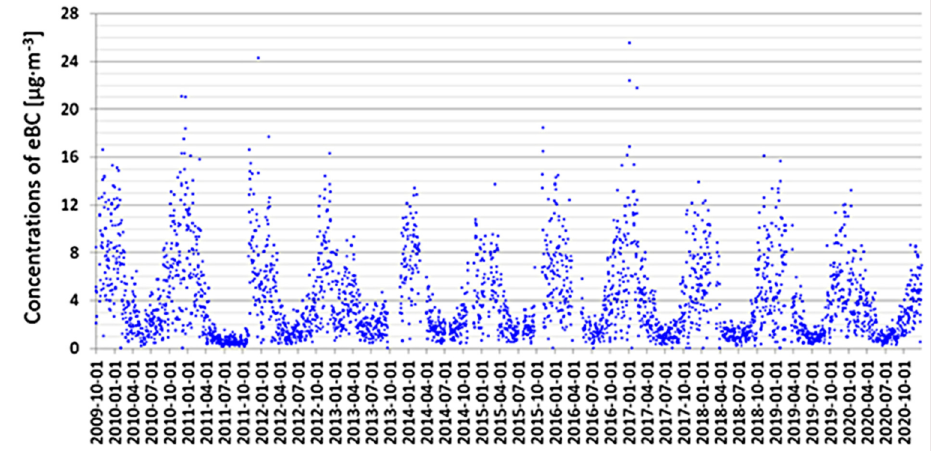
Figure 4. Time series of daily eBC concentration ( µ g · m − 3 ) in individual